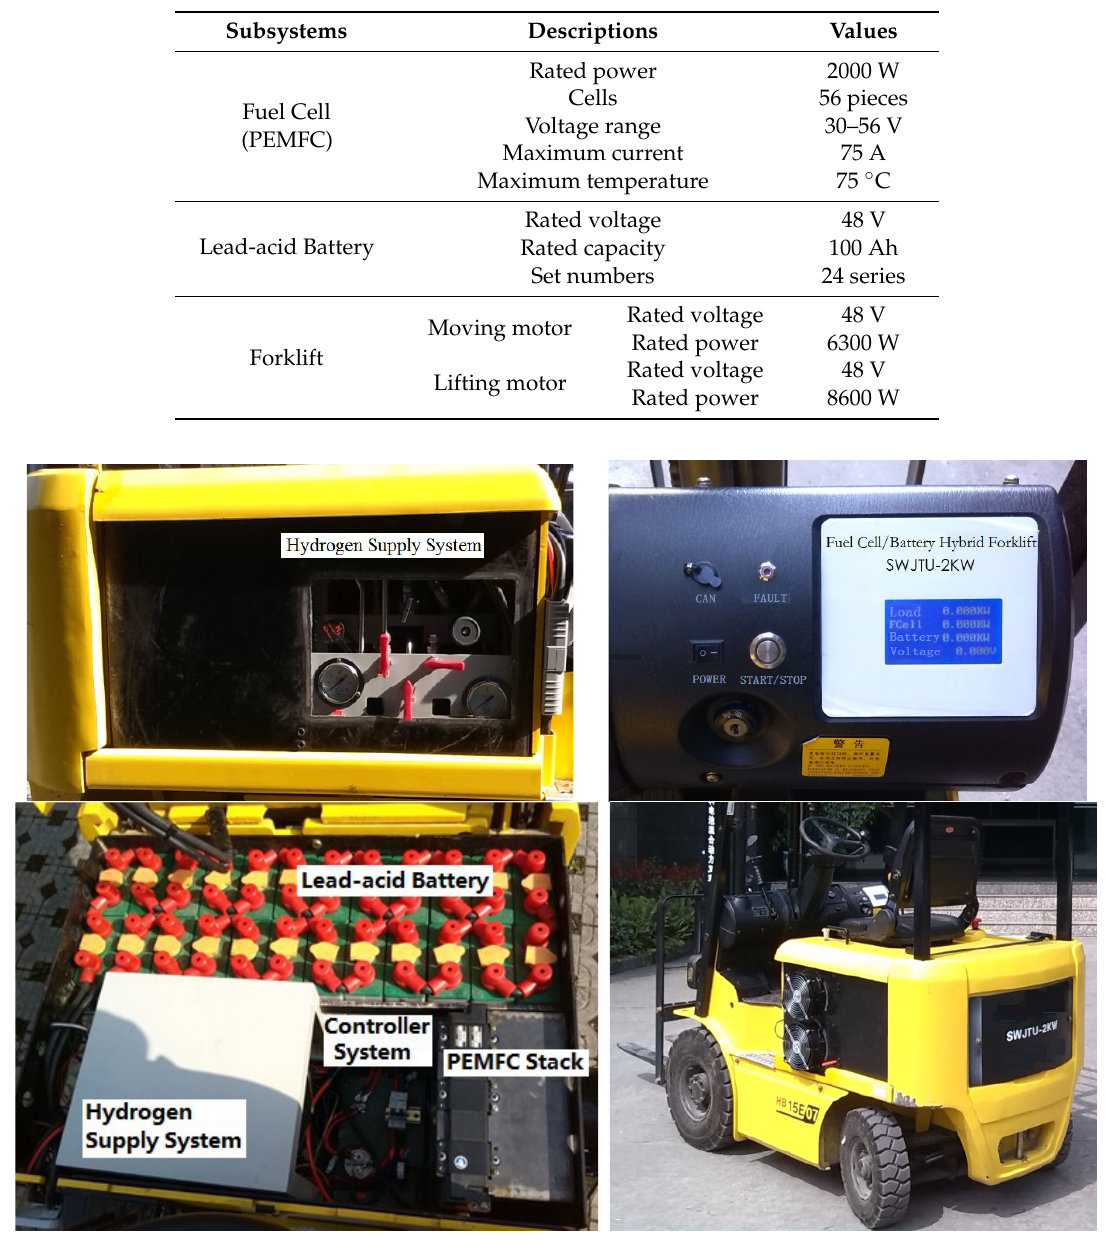
Table 2. Parameters of the hybrid system.